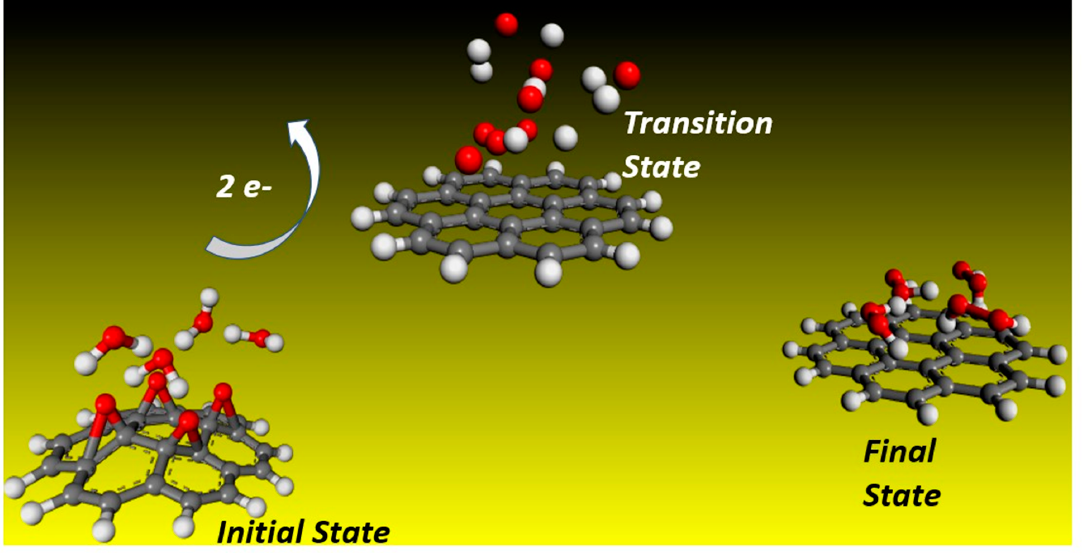
Figure 7. Geometrically optimized molecules of doubly-charged graphene Gr24-6 catalyzing the water conversion to peroxide, indicated by initial, transition and final states. Carbon, oxygen and hydrogen are represented by the gray, red and white spheres, respectively. Note, here as well, that the bonds are broken in the transition state. Table 1. Rank-ordered activation energy barrier reduction, E(eV), for doubly-charged negative ionic systems,